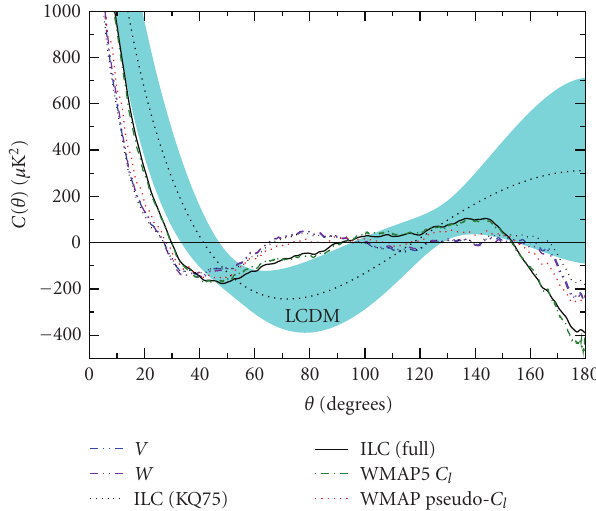
Figure 5: Two-point angular correlation function, C ( θ ), computed in pixel space, for three di ff erent bands masked with the KQ75 mask (from WMAP 5 year data). Also shown are the correlation function for the ILC map with and without the mask, and the value expected for a statistically isotropic sky with best-fit Λ CDM cosmology together with 68% cosmic variance error bars. Even by eye, it is apparent that masked maps have C ( θ ) that is consistent with zero at θ (cid:3) 60 deg. We also show the C ( θ ) computed from the “o ffi cial” published maximum likelihood estimator-based C (cid:2) . Clearly, the MLE-based C (cid:2) , as well as C ( θ ) computed from the full-sky ILC maps, is in significant disagreement with the angular correlation function computed from cut-sky maps. Adopted from